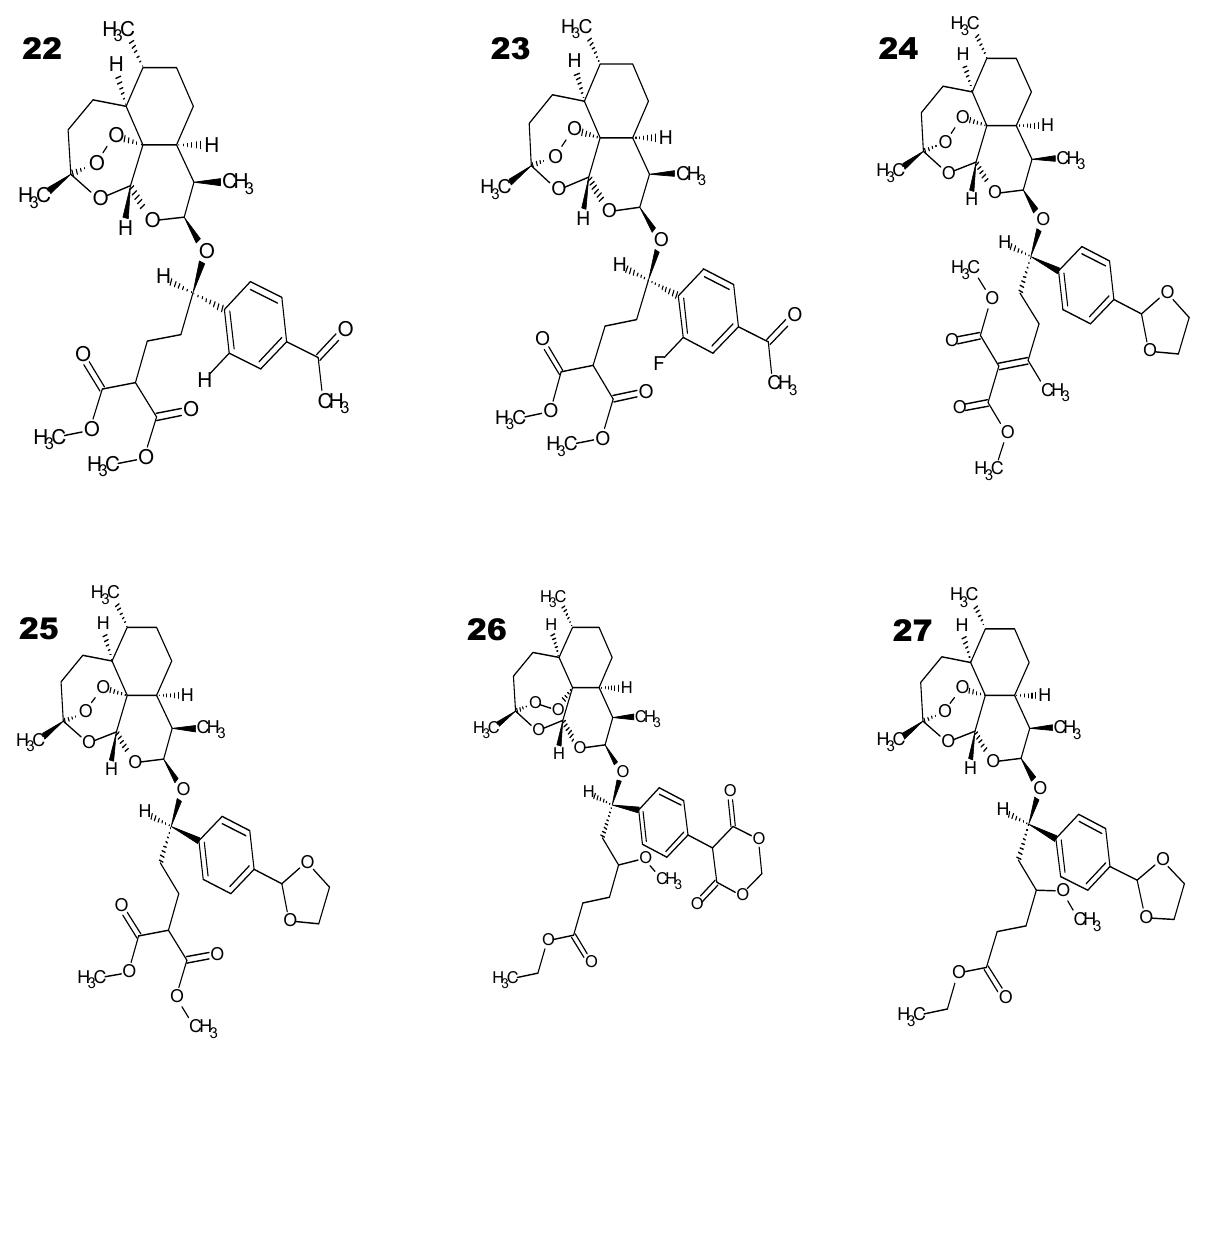
Figure 8. Compounds of the test set artemisinin derivatives with unknown antimalarial activity against Plasmodium falciparum type